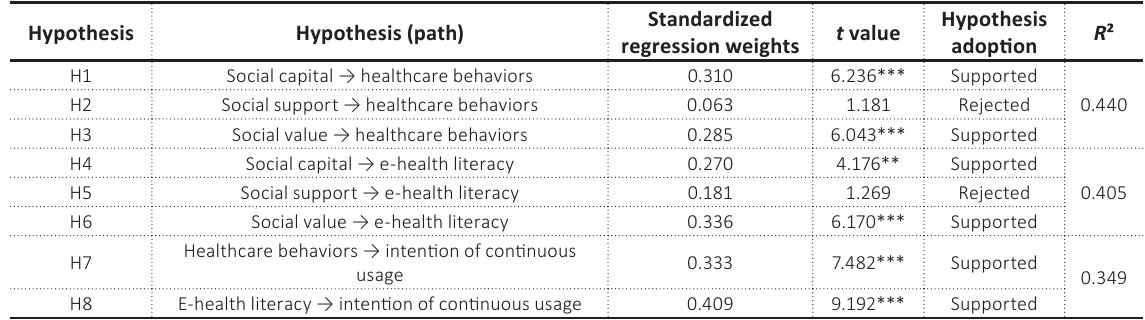
Table 4. Hypothesis test